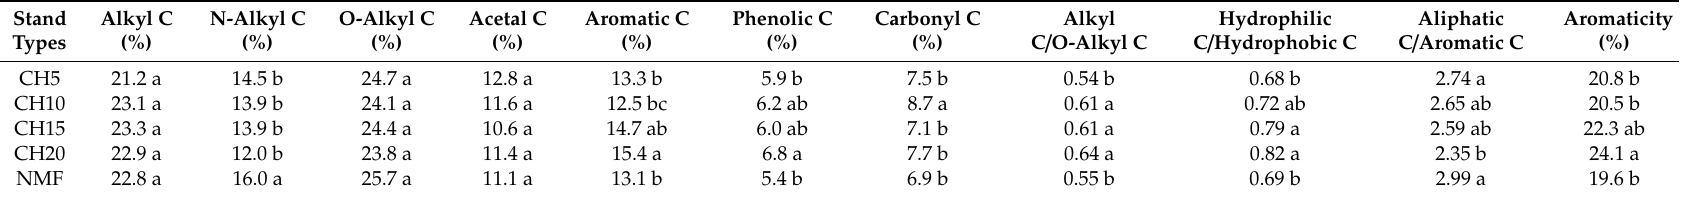
Table 4. Signal intensity distribution of di ff erent carbon fractions in the 13C NMR spectra of soil organic carbon from natural broad-leaved forest and Chinese hickory stands managed intensively for 5, 10, 15, and 20